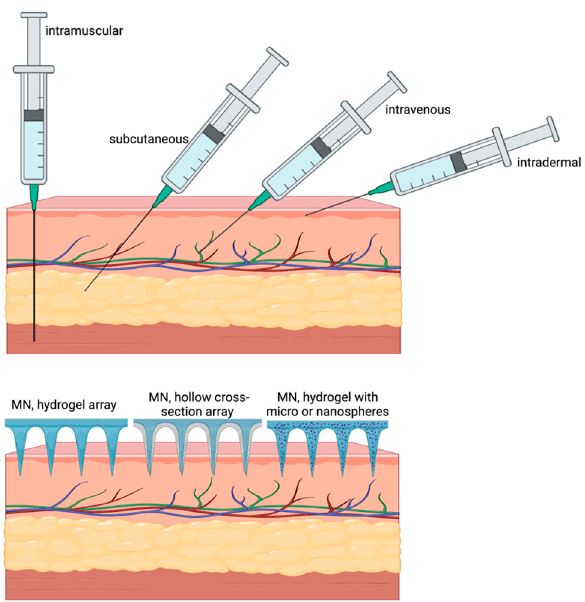
Figure 4. Parenteral and microneedle injections (Illustration created with BioRender [29]).